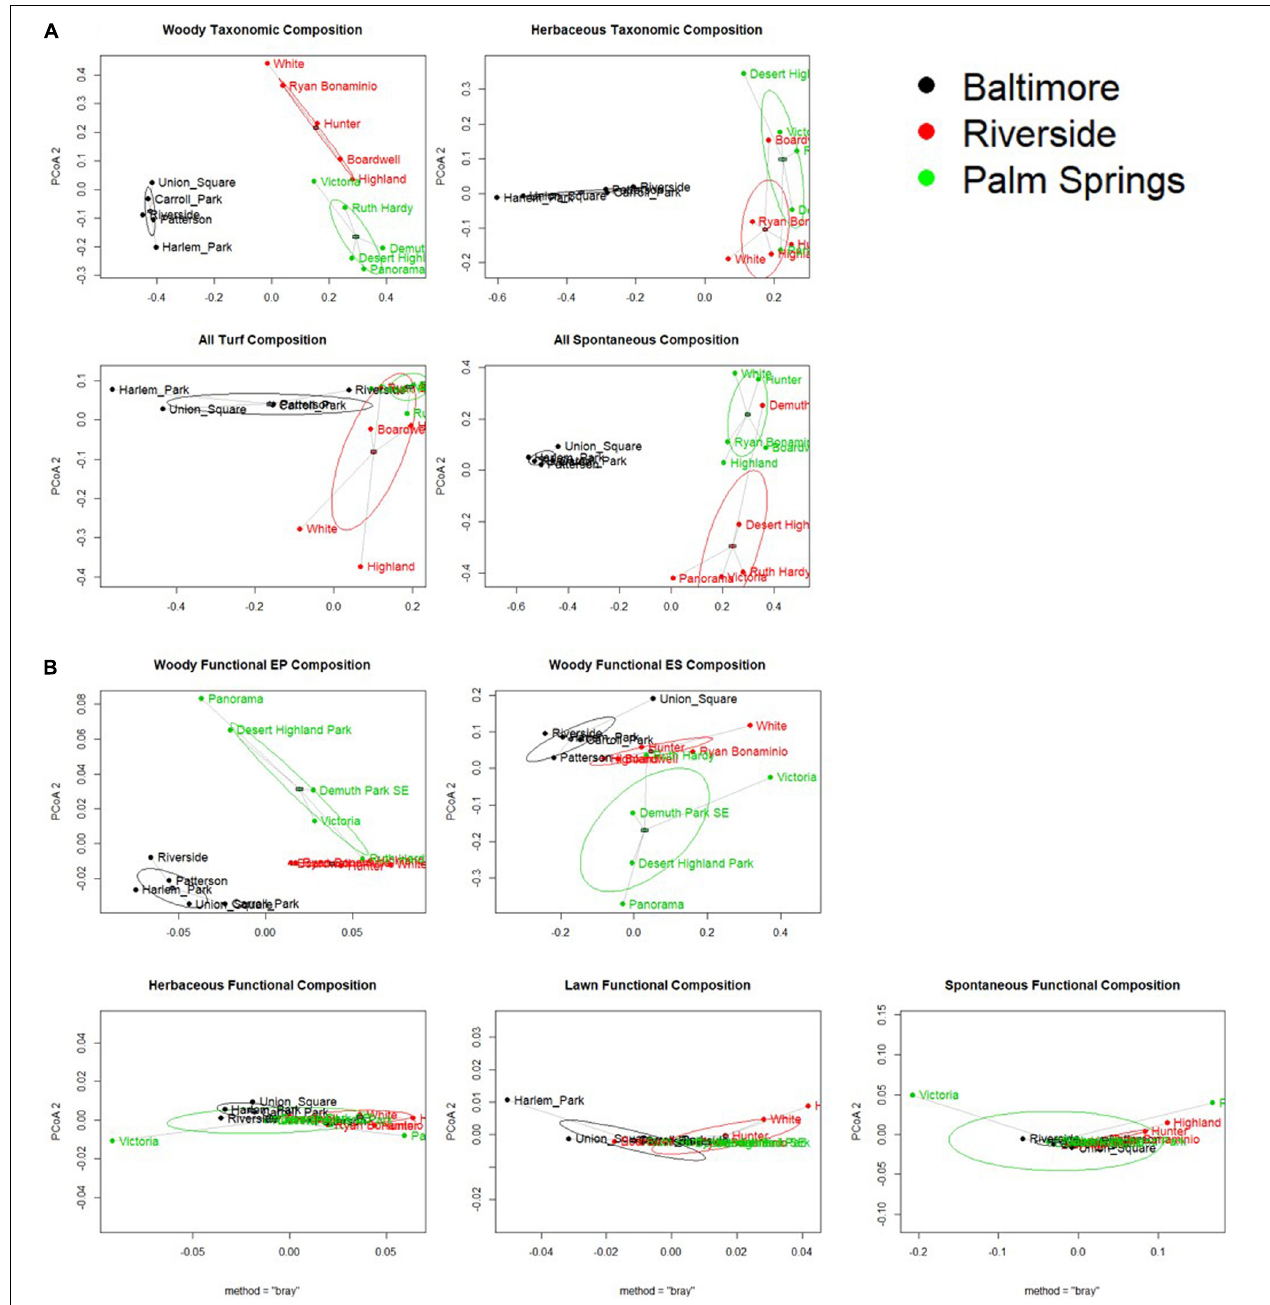
FIGURE 5 | Principal Coordinates Analysis of Beta Diversity for (A) Taxonomic Diversity, and (B) Functional Diversity, for all vegetation types. Point represent a sampled park and are colored and labeled based on city of location. Difference of points is calculated as bray-curtis distance. Ellipses are one standard deviation of the